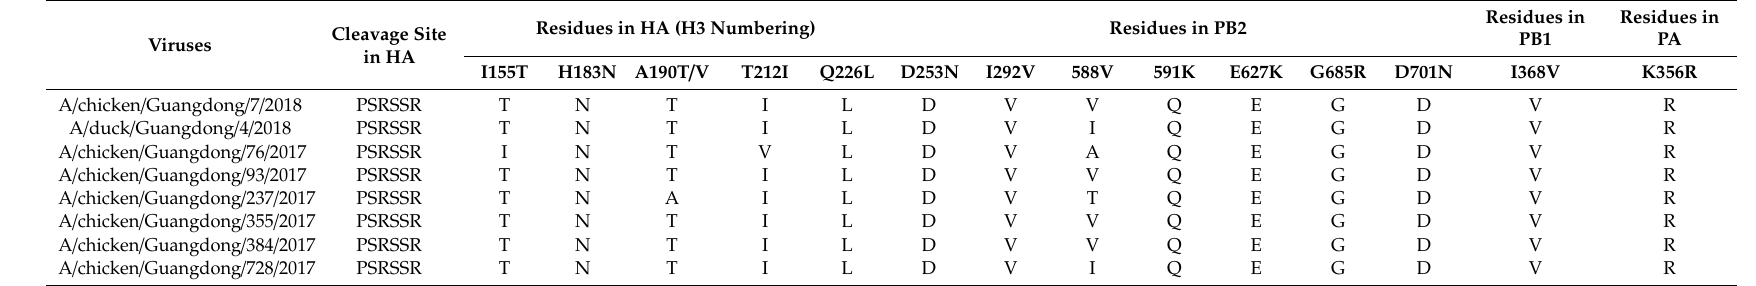
Table 1. The molecular characteristics of the H9N2 influenza viruses used in this study.